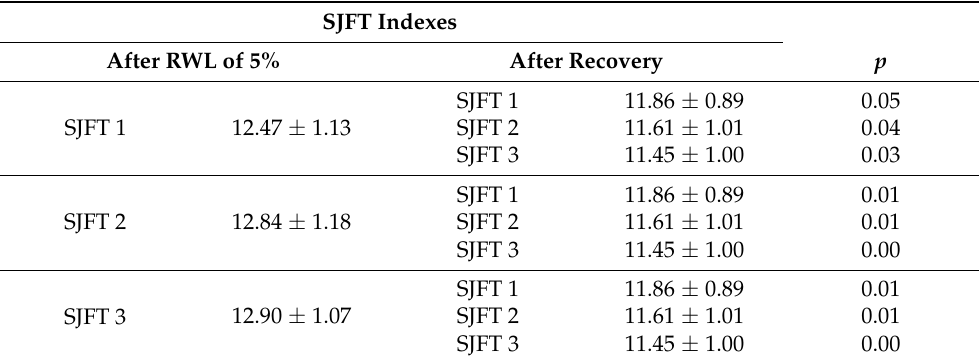
Table 5. Changes in SJFT index between measurements after RWL and after 15 h recovery of RWL group. SJFT Indexes After RWL of 5% After Recovery p SJFT 1 11.86 ± 0.89 0.05 12.47 ± 1.13 SJFT 2 11.61 ± 1.01 0.04 SJFT 1 SJFT 3 11.45 ± 1.00 0.03 SJFT SJFT 2